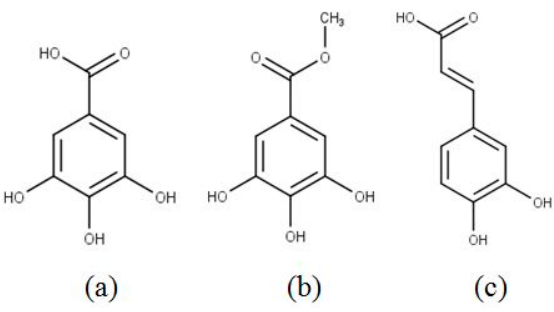
Figure 1. Chemical structure of phenolic compounds ( a ) gallic acid, ( b ) methyl gallate, ( c ) caffeic acid.